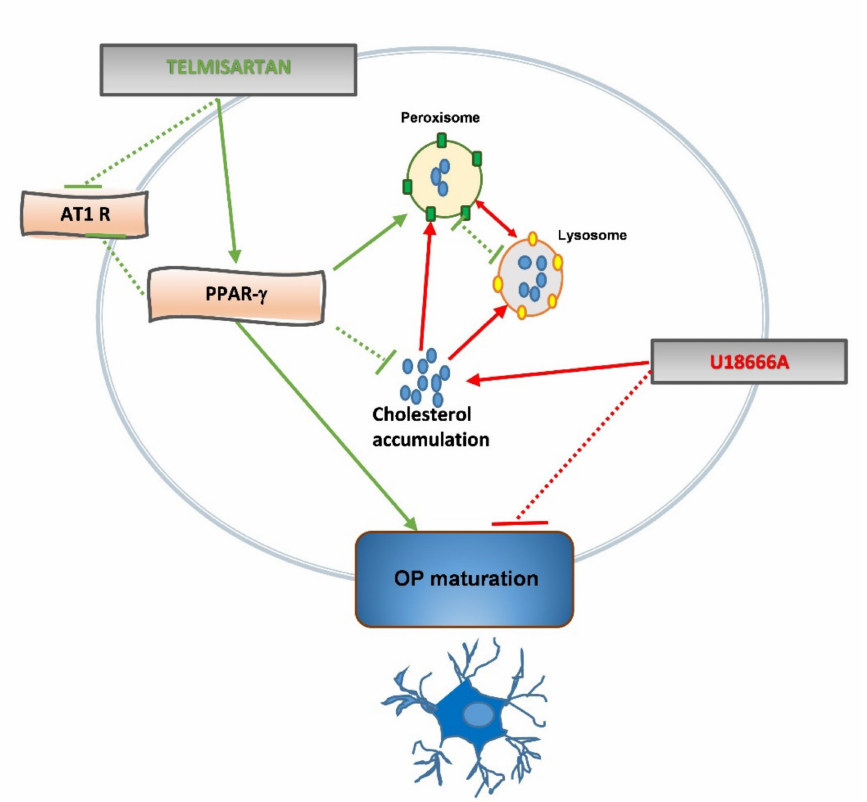
Figure 8. Schematic representation of TLM effects on OPs. TLM activates PPAR- γ in OPs, blocks AT1 activation, controls cholesterol metabolism and promotes OL differentiation by a PPAR- γ -dependent mechanism. TLM protects OP from the pathological effects induced by U18666A, modulating cholesterol traffic in the lysosome and peroxisome, and recovering maturation arrest. TLM and U18666A effects are illustrated by green and red lines, respectively. Solid arrows depict positive interactions. Broken lines indicate an inhibitory